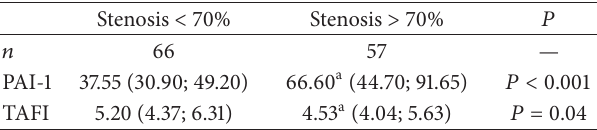
Table 3: Plasma fibrinolysis markers considering stenosis of 70% as clinical cut point for intervention.